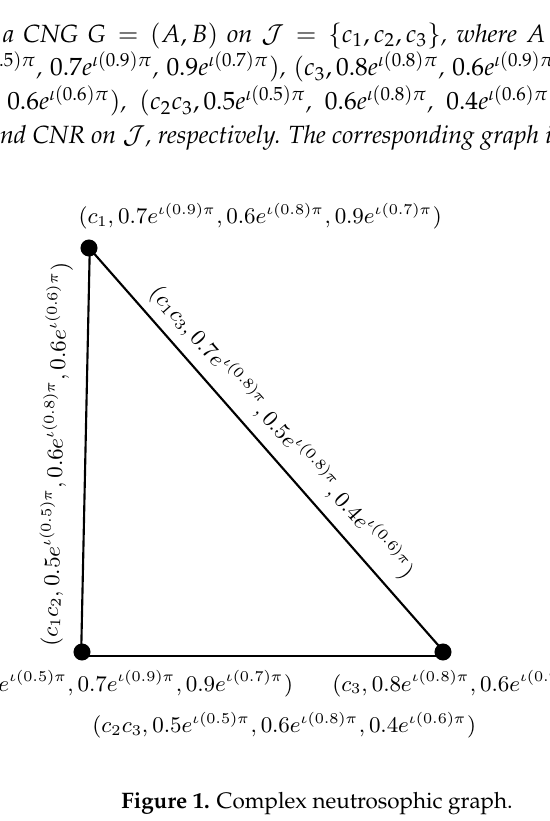
Figure 1. Complex neutrosophic